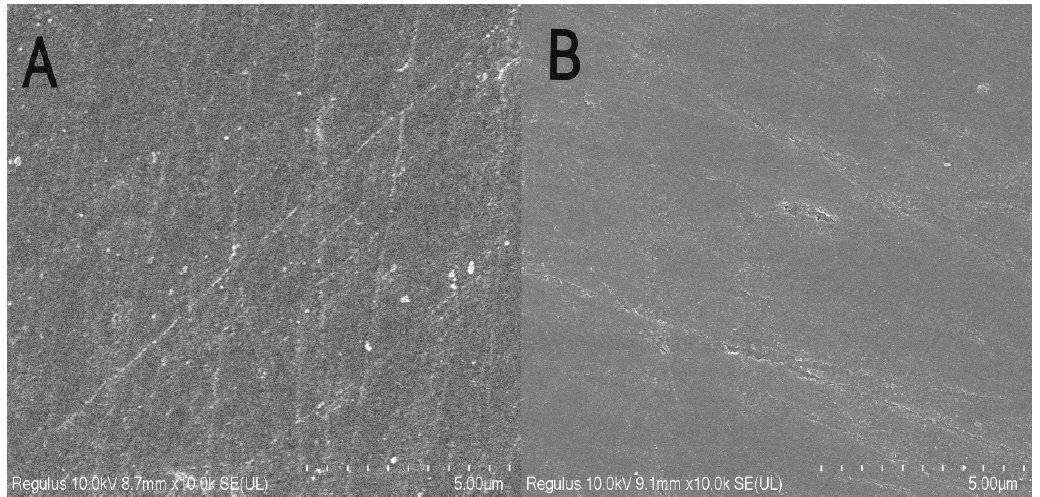
Figure 2. SEM image of glassy carbon electrode. ( A ), after polishing the electrode; ( B ), before polishing the electrode.